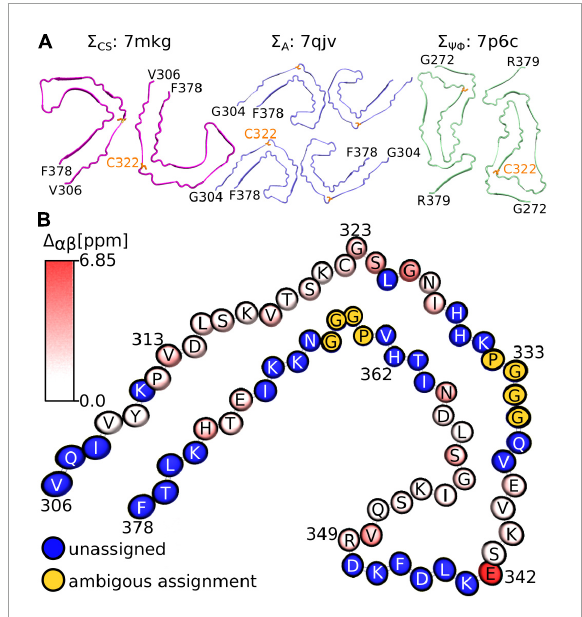
FIGURE5 Fibril structures best fitting to NMR assignment. (A) Top view of fibril structures that fit best using the (cid:54) CS metric (7mkg), the (cid:54) A metric (7qjv, 7p6d not shown), and the (cid:54) (cid:57)(cid:56) metic (7p6c). The N and C-terminal residues are indicated in black, C322 is highlighted in orange. (B) Birds-eye view on chain A of PDB entry 7mkg. Assigned residues are colored according to the per residue C α and C β chemical shift difference calculated using the program ShiftX2 i.e., (cid:49) αβ = | δ C α Cal i − δ C α NMR i | + | δ C β Cal i − δ C β NMR | . Unassigned residues are shown in blue. The PGGG i sequences that were ambiguously assigned are shown in yellow. Residue number and type are indicated. Panel (B) was made with the help of the program